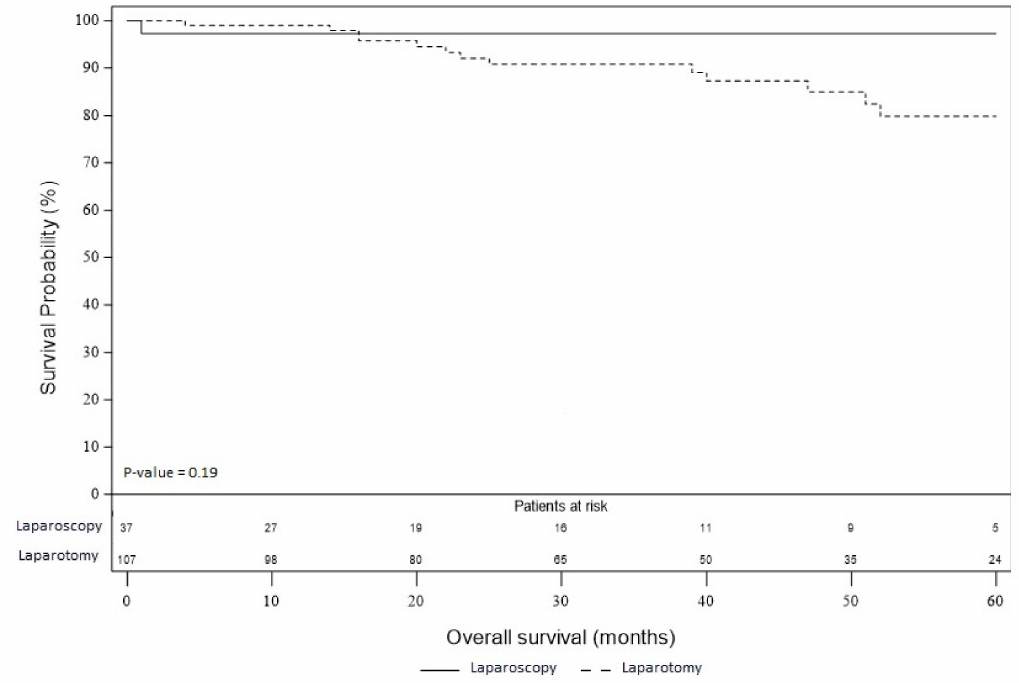
Figure 3. Overall survival of the laparoscopy and laparotomy